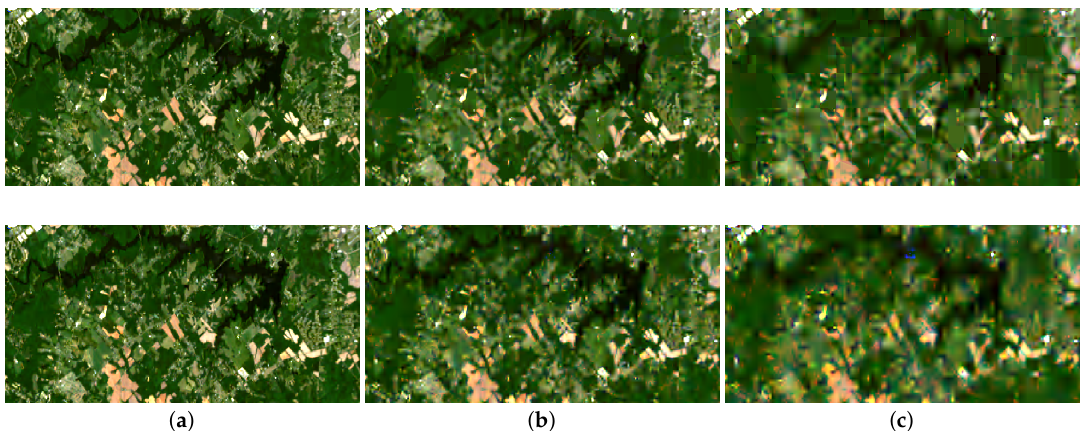
Figure 9. HEVC ( upper row ) vs. JPEG 2000 ( lower row ) on the example of an 30 m Landsat-8